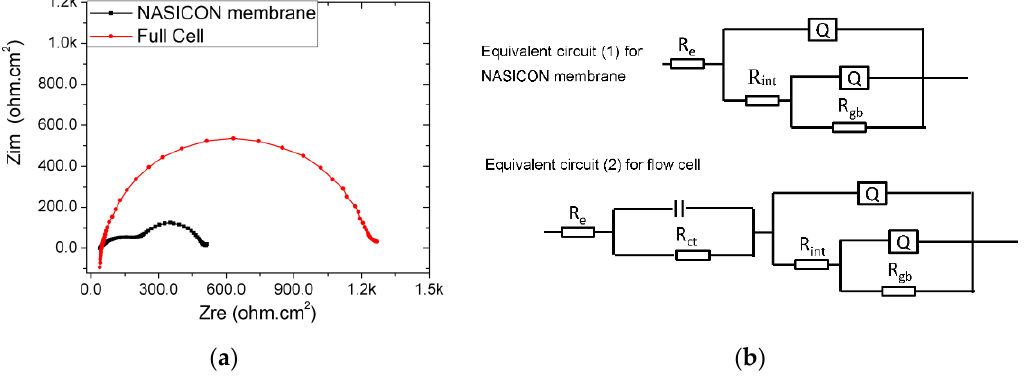
Figure 5. ( a ) The Nyquist plots of the NaSICON membrane and Na-Cs‖NaI flow cell with apparent area of ~4 cm 2 , and ( b ) the equivalent circuits for the simulation of the impedance spectra in (a). The Nyquist plot of the NASICON membrane was obtained from a NaClO 4 (1 M aq.) | NaSICON | NaClO 4 (1 M aq.) symmetric cell, whereas the corresponding plot of the flow cell was from Na 37 Cs 63 | NaSICON | 0.25M NaI aqueous solution, measured at the open-circuit voltage of the cell in the frequency range of 100k–0.1 Hz with ac signal amplitude of 10 mV. For the flow cell, graphite felt GFD5.0 was used as the electrode and current collector of the cathode, whereas stainless steel casing was used as the current collector of the anode. Similar equivalent circuits (1) and (2) have been used previously to simulate the impedance spectra of a Li-ion conducting membrane and a Li | solid electrolyte | LiBr aqueous solution cell, respectively [14].